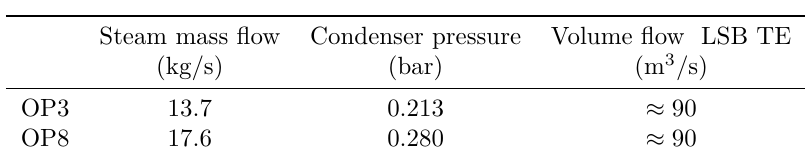
Table 1. The main operating parameters of the OP3 and OP8.